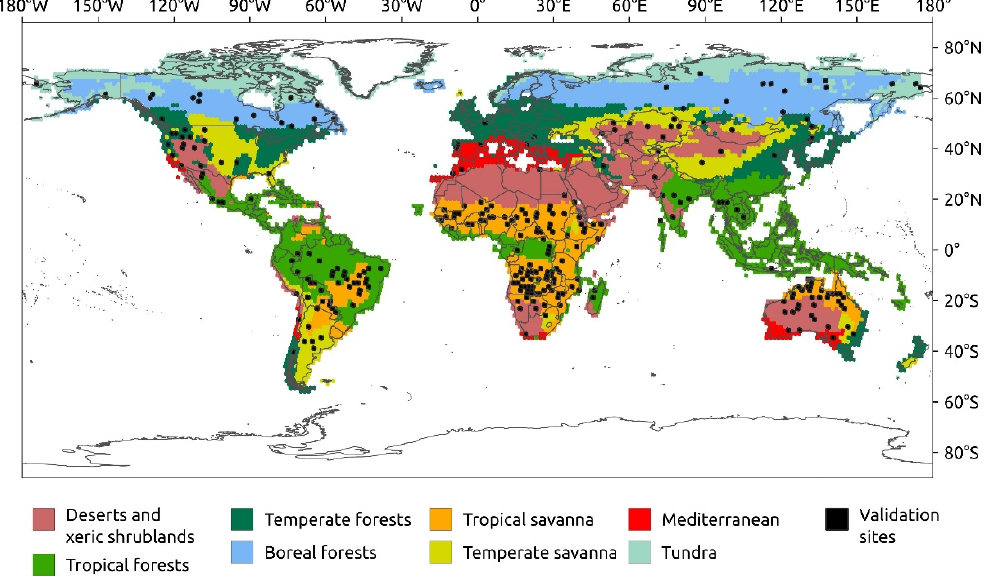
Figure 4. Biomes representing the first stratum of validation sampling. The black locations show the 300 validation sites that were selected for 2017, 2018, and 2019 (100 for each year).